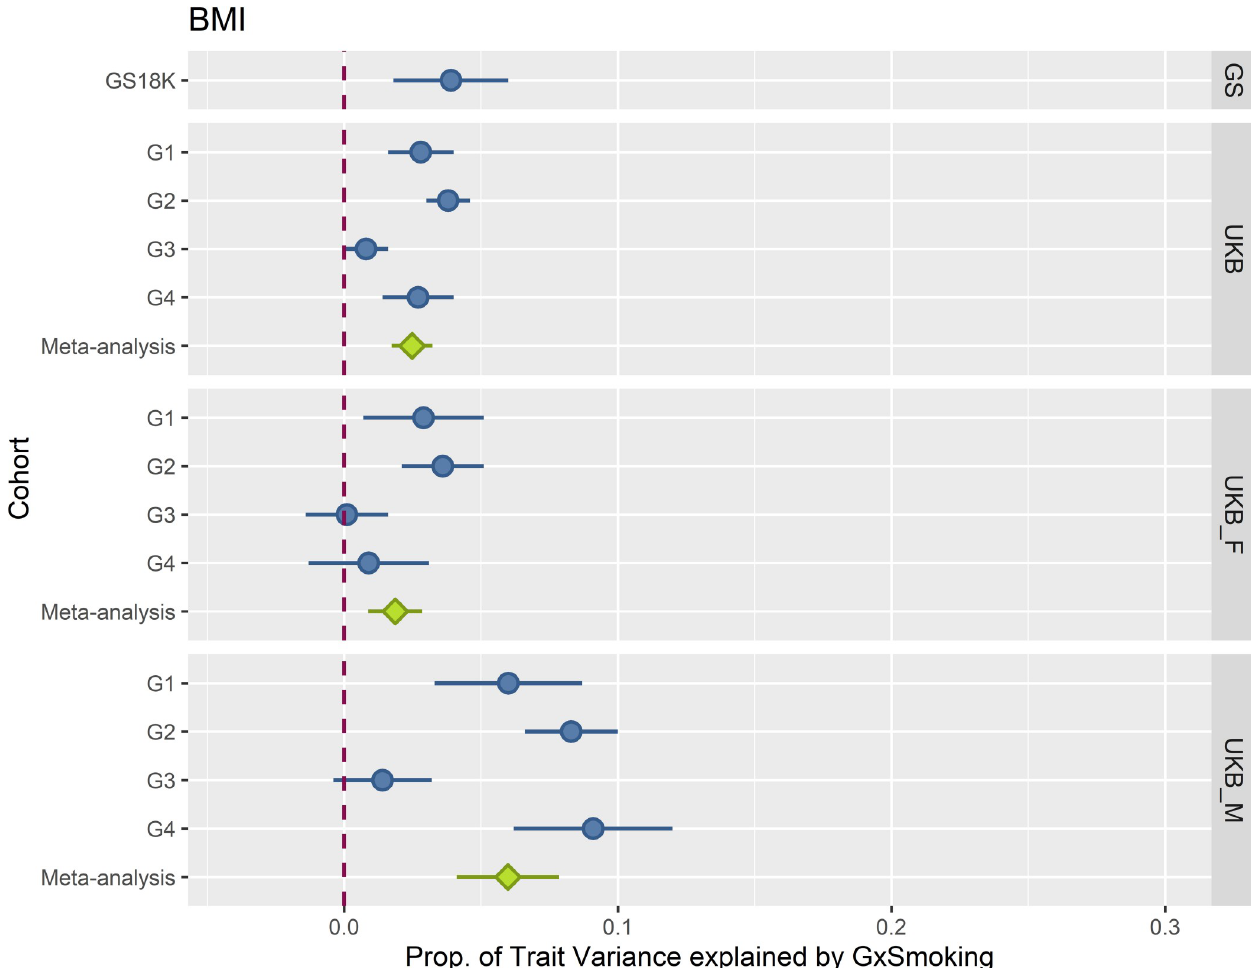
Fig 3. Proportion of BMI variation explained by Genome-by-Smoking interactions across all cohorts and sub-cohorts. The plot shows the proportion of BMI variance (the bars represent standard errors) explained by the genome-by-smoking interaction (x-axis) in the mixed model analyses across cohorts (y- axis). Panels from top to bottom represent cohorts: Generation Scotland (GS), UK Biobank (UKB), UK Biobank females (UKB_F) and UK Biobank males (UKB_M). Blue coloured data points show sub-cohort results, green coloured data points show meta-analyses of the corresponding panel sub-cohorts.